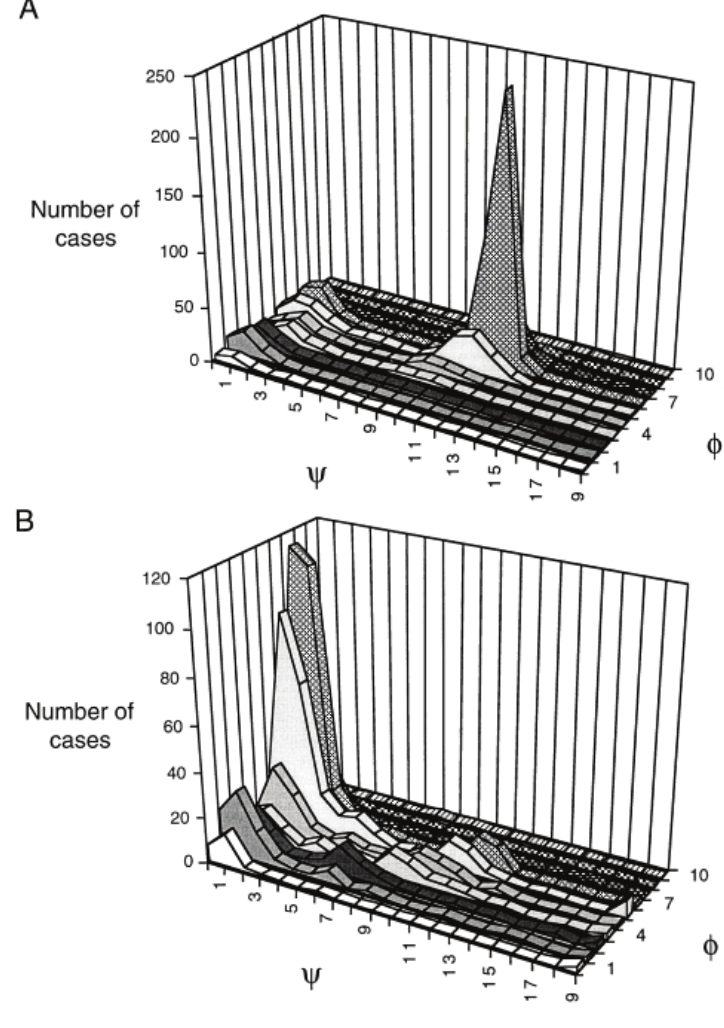
Figure 17. Distribution obtained in the upper left quadrant of the Ramachandran plot for Alanine using ( A ) all secondary structure conformations in the protein database ( i.e. , an unrestricted library) or ( B ) only those alanine residues in a coil conformations ( i.e. , helices, sheets, turns omitted). The number of cases was normalized values to 1000. Each axis marker represents an 18° interval. Taken from ref. [75] with